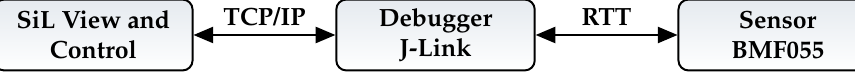
Figure 5. Communication protocols used on the setup.